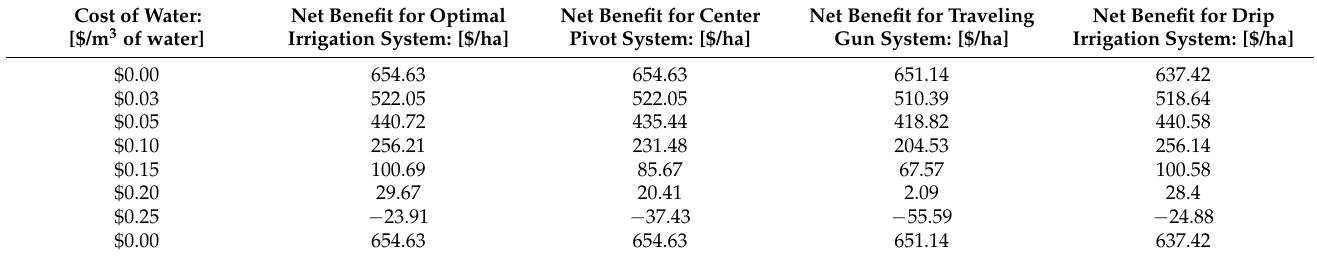
Table A6. Net benefit values associated with wheat production for each irrigation system under various water cost values. Cost of Water: Net Benefit for Optimal Net Benefit for Center Net Benefit for Traveling Net Benefit for Drip [$/m 3 of water] Irrigation System: [$/ha] Pivot System: [$/ha] Gun System: [$/ha] Irrigation System: [$/ha] $0.00 288.94